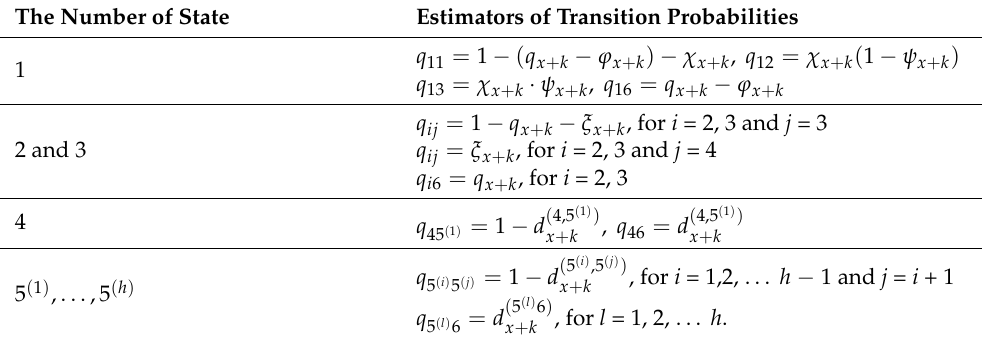
Table 1. The formulas for the estimators of the transition probabilities for health insurance.